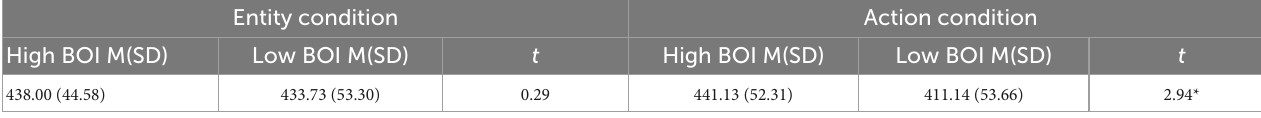
M,mean;SD,standarddeviation.*Indicates p <